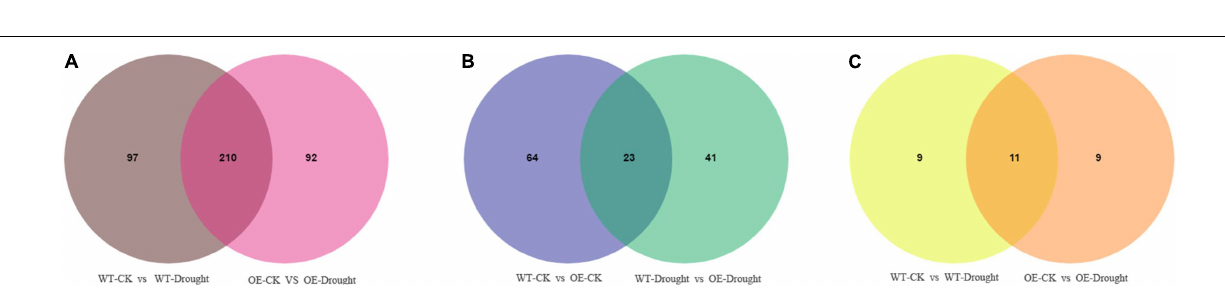
Frontiers in Plant Science |